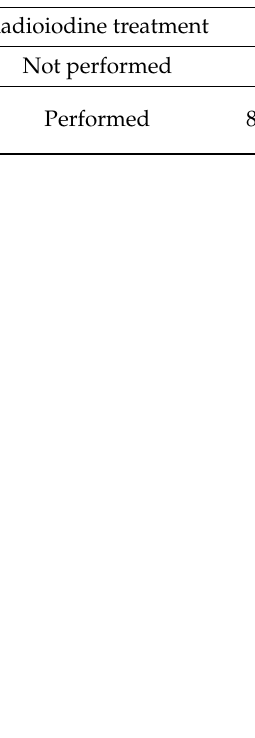
Table 3. Three patients died from thyroid